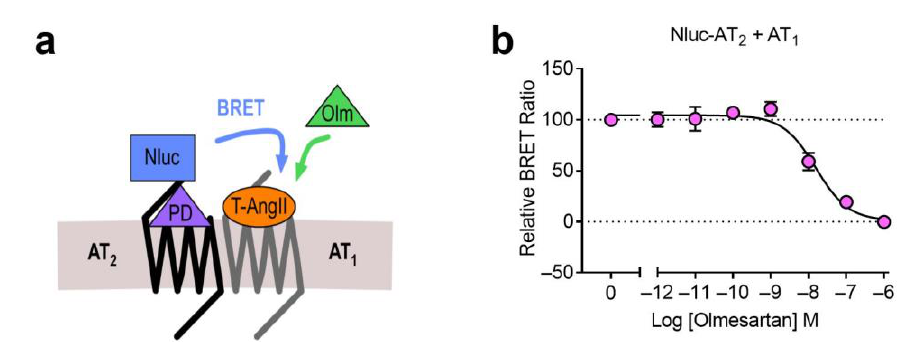
Figure 9. Competition binding of TAMRA-AngII to the AT 1 -AT 2 heteromer. Cells expressing Nluc-AT 2 and untagged AT 1 ( a ) were treated with 100 µ M PD 123319 (PD), 1 µ M TAMRA-AngII (T-AngII) and increasing concentrations of olmesartan (Olm) ( b ). Data are normalized (100% being vehicle treated and 0% being 1 µ M olmesartan treated) and displayed as relative BRET ratio, mean ± SEM of three independent experiments.